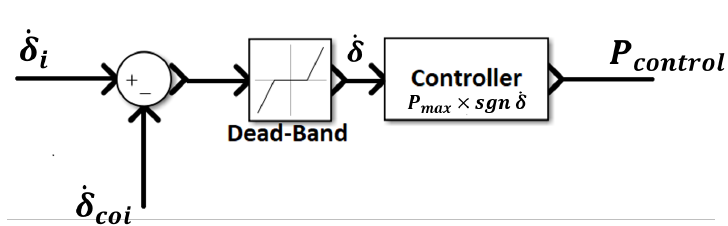
Figure 12. Block diagram of controller.